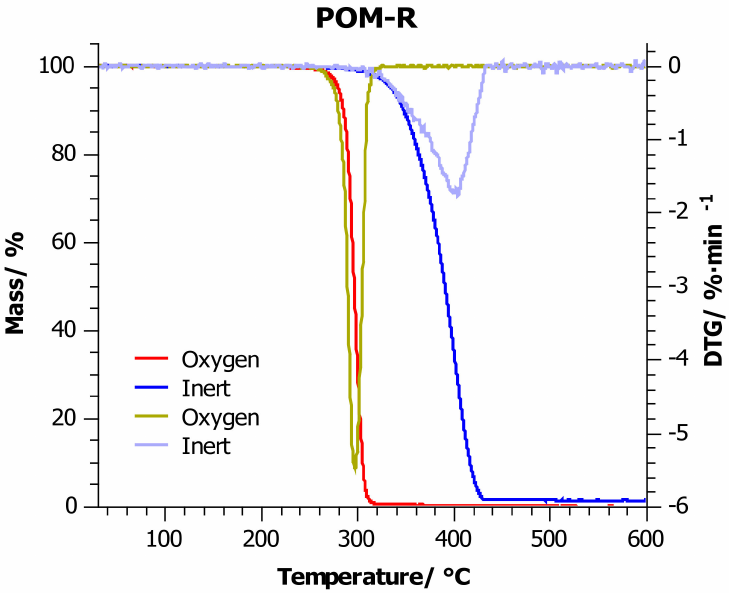
Figure 4. TG thermograms for POM-R sample: red line—investigations carried out in oxygen atmosphere; blue line—investigations carried out in the inert atmosphere, at a heating rate of 10 ◦